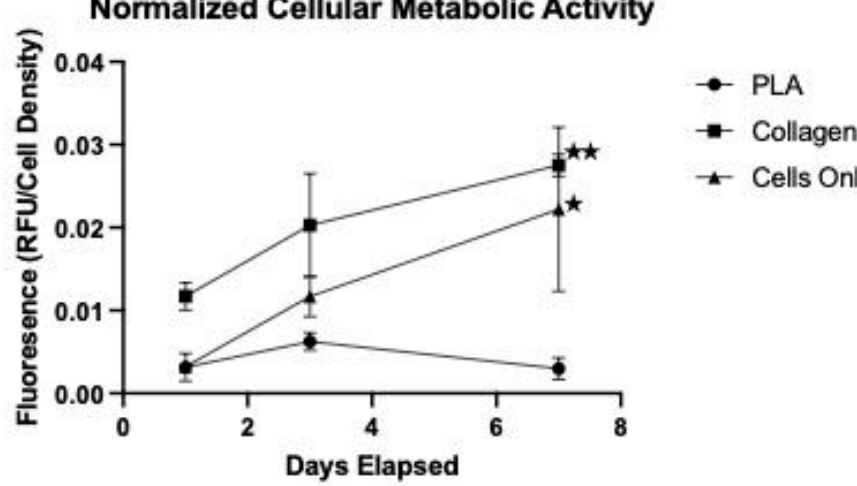
Figure 4. Cellular Proliferation by the Metabolic assay, as measured in arbitrary fluorescence units (RFU) indicated by the alamarBlue™ assay. The RFU values were normalized in relation to the cell density plated. The error bars represent standard deviations. ★ indicates a statistically significant difference between the Cells-only and PLA samples at p < 0.05. ★★ indicates a statistically significant difference between the Collagen and Cells-only samples at p < 0.05 ( n = 3 for all samples).